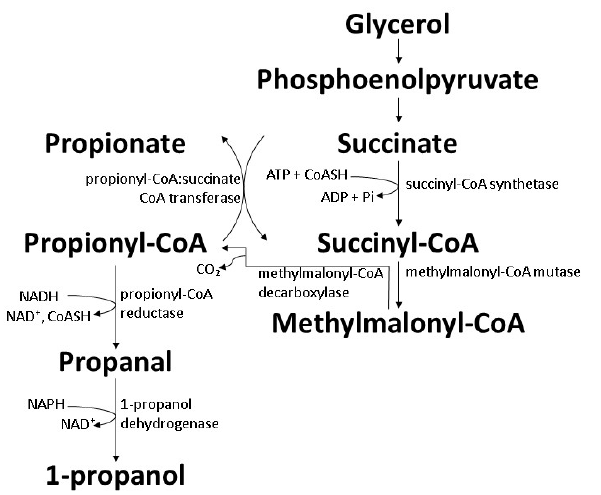
Figure 10. Biosynthesis of 1-propanol by genetically engineered E. coli BW25113 with activated SBM operon for extended dissimilation of succinate [118].